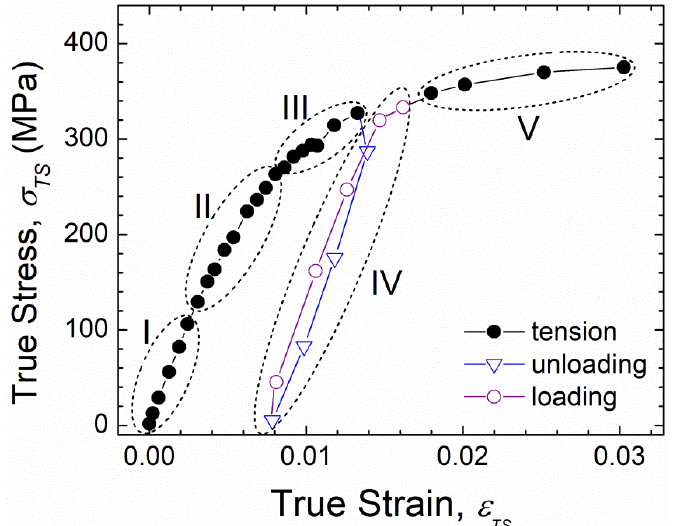
Figure 2. Dependence of macroscopic true stress ( σ TS ) and on true strain ( ε TS ) for bulk nc-Ag. Five dashed ovals representing the five deformation regimes (I to V). Metals 2020 , 10 , x FOR PEER REVIEW 6 of 14